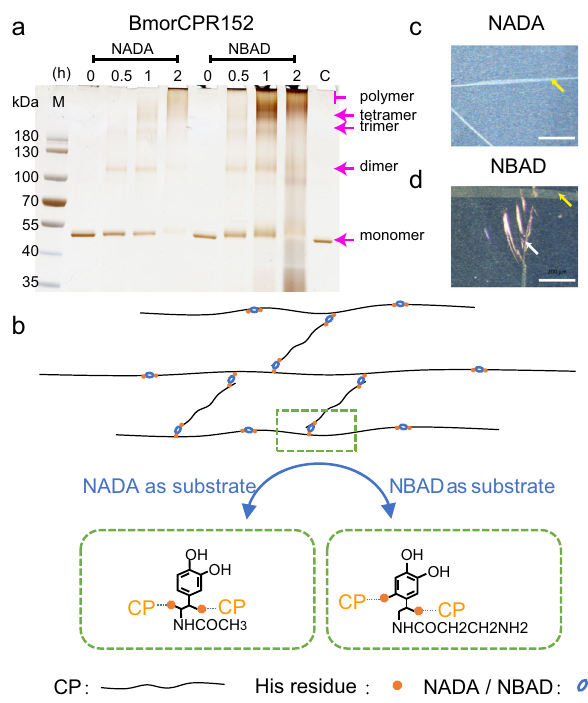
Fig. 5 Crosslinking of BmorCPR152 with Bmlac2A and NADA/NBAD in vitro. a Products of in vitro crosslinking reactions of BmorCPR152, examined by SDS-Page gel electrophoresis. b Schematic diagram of the crosslinking of CPs. Green box, interaction between histidine residues (orange dots) and NADA/NBAD (blue ovals). c , d Films synthesized using NADA or NBAD as substrate. Part of the fi lms removed from the reaction buffer and observed microscopically; Scale bar = 200 μ m. c A white fi lm synthesized using NADA as the substrate; d A golden fi lm synthesized when NADA was replaced by NBAD. Yellow arrows, wrinkles on fi lms; white arrow, light interference occurring in the wrinkled